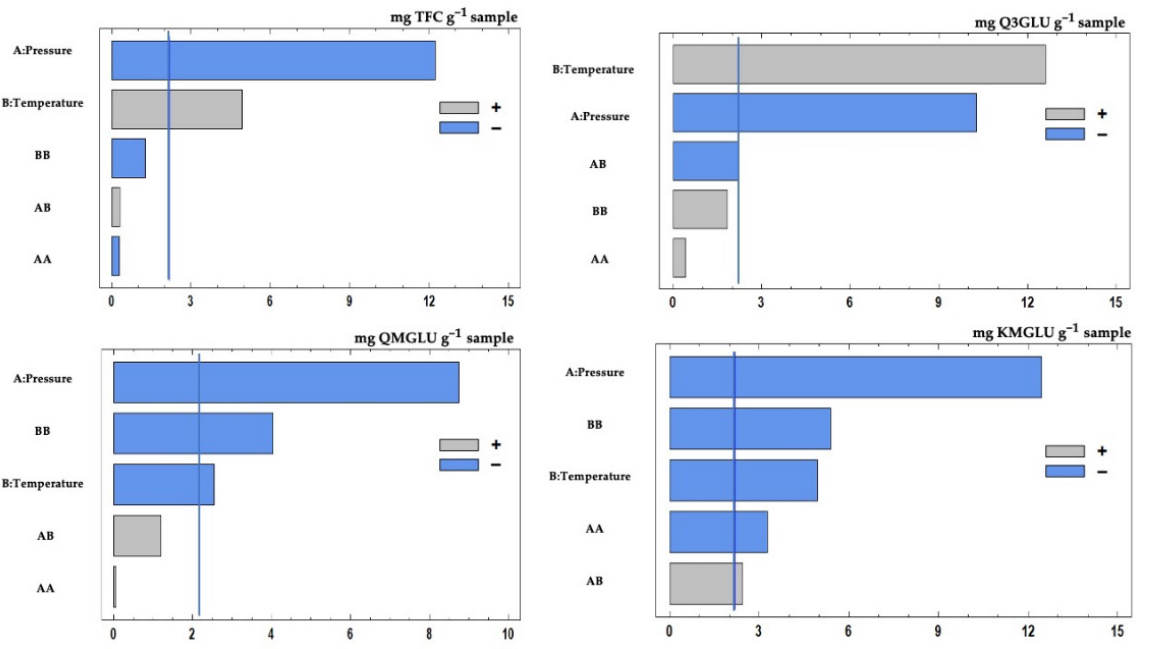
Figure 2. Pareto chart of the standardized effects on TFC, Q3GLU, QMGLU and KMGLU concentrations. TFC, Q3GLU, QMGLU and KMGLU concentration data have been graphically repre- sented using a standardized Pareto chart (Figure 2), where both the linear and quadratic effects and their interactions have been plotted in a decreasing order of significance. The vertical line represents the statistically significant limit at a 95% confidence level and,